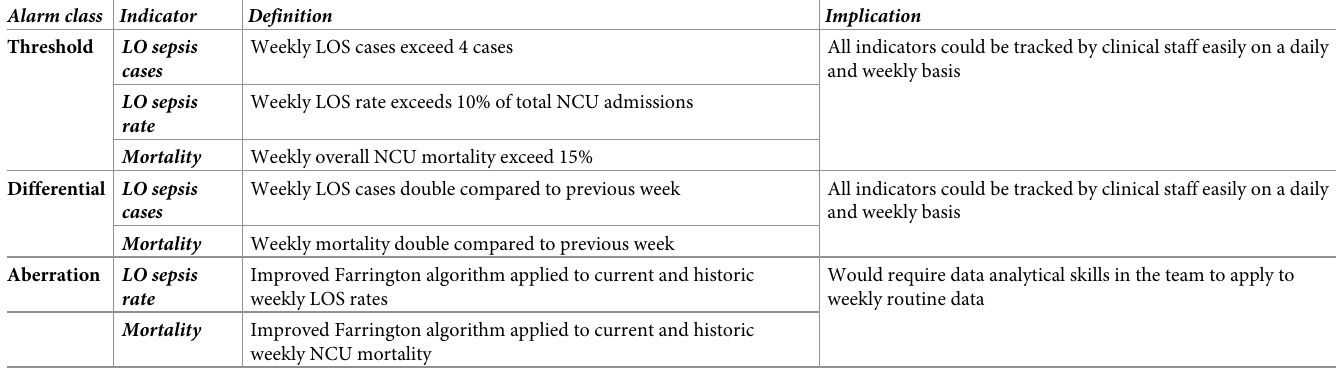
Table 1. Classes of outbreak alarms, how they are defined and their